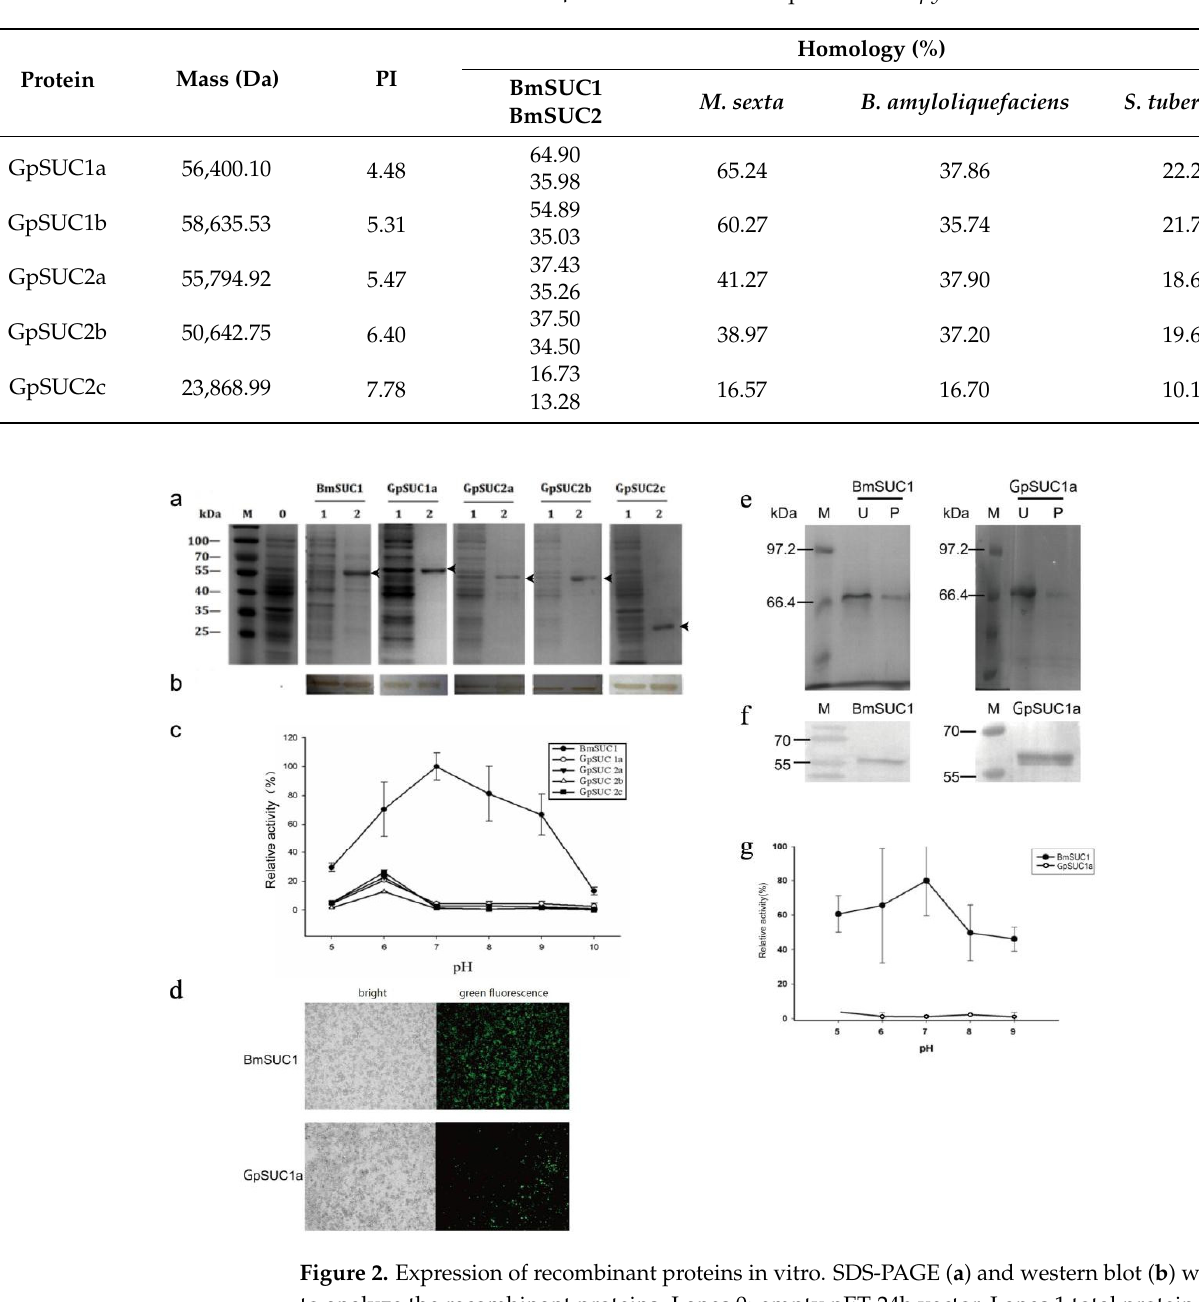
Table 2. Characteristics of β -FFase amino acid sequences of G. pyloalis .